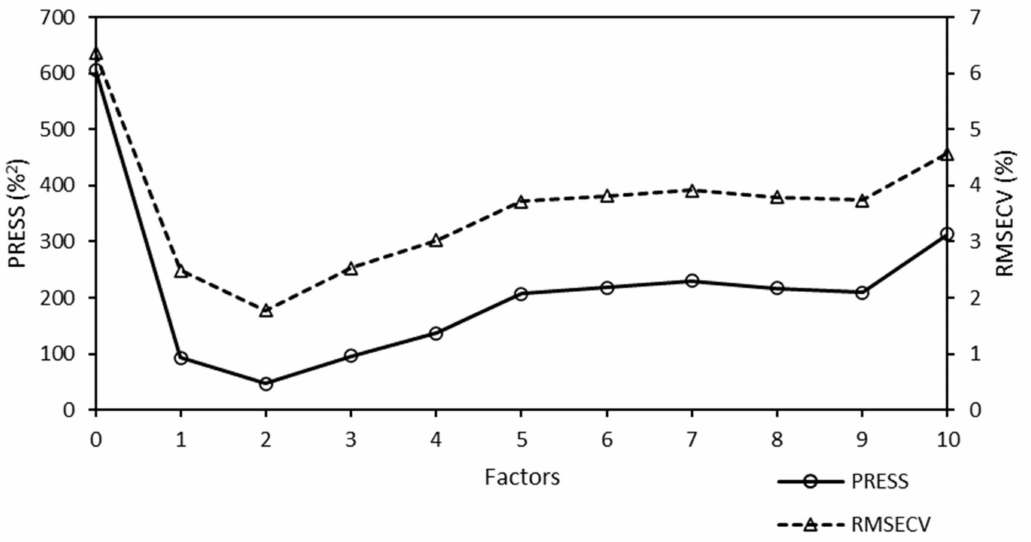
Figure 11. Predicted residual error sum of squares (PRESS) diagnostic function of the Raman model used for the analysis of the Mo content of Mo-supported beta zeolite catalysts. The minimum PRESS / RMSECV value was achieved using two factors. Here, RMSECV denotes the root mean square error of cross